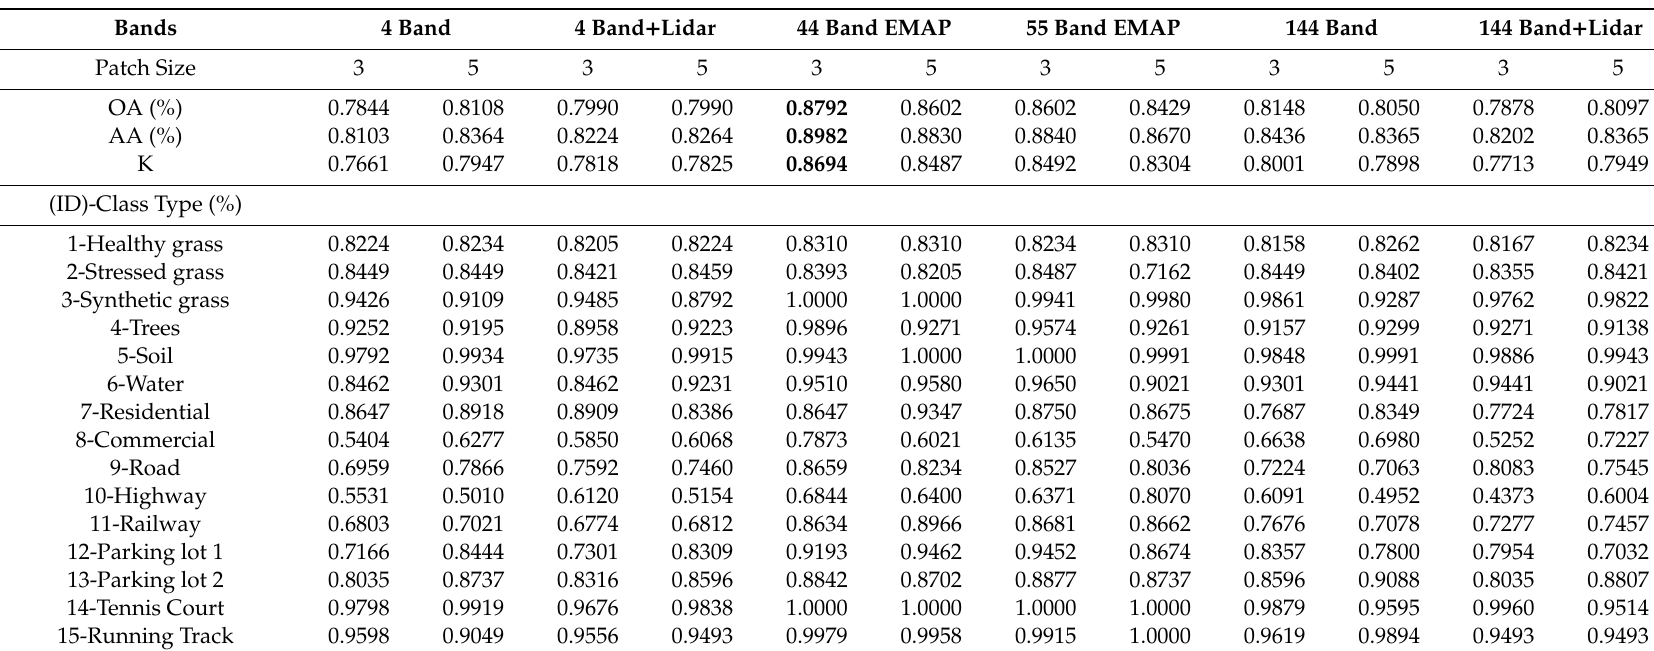
Table 2. Classification results obtained by our customized CNN model for the considered test dataset with six di ff erent sets of image bands. Bold numbers indicate best performing datasets for each